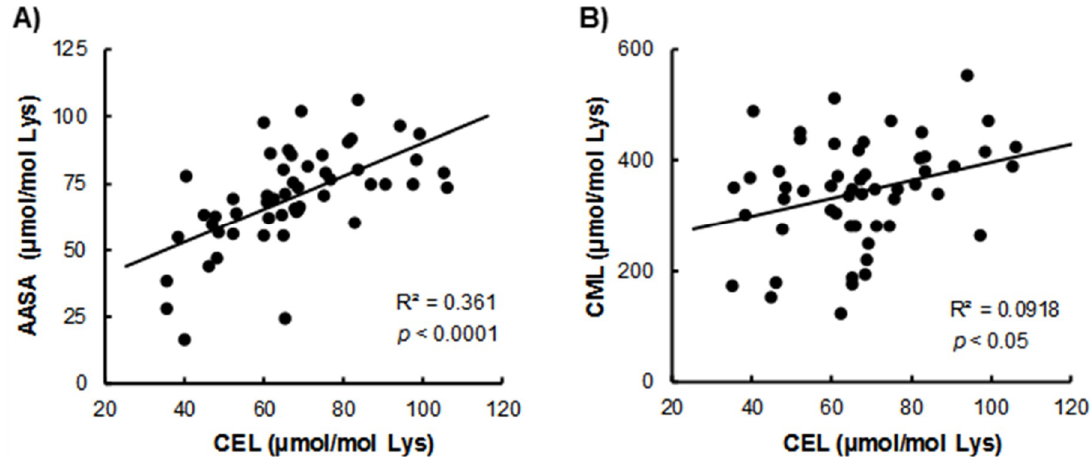
Figure 3. Correlations of ( A ) AASA and ( B ) CML with CEL in follicular fluid. Samples were obtained from natural and stimulated cycles.